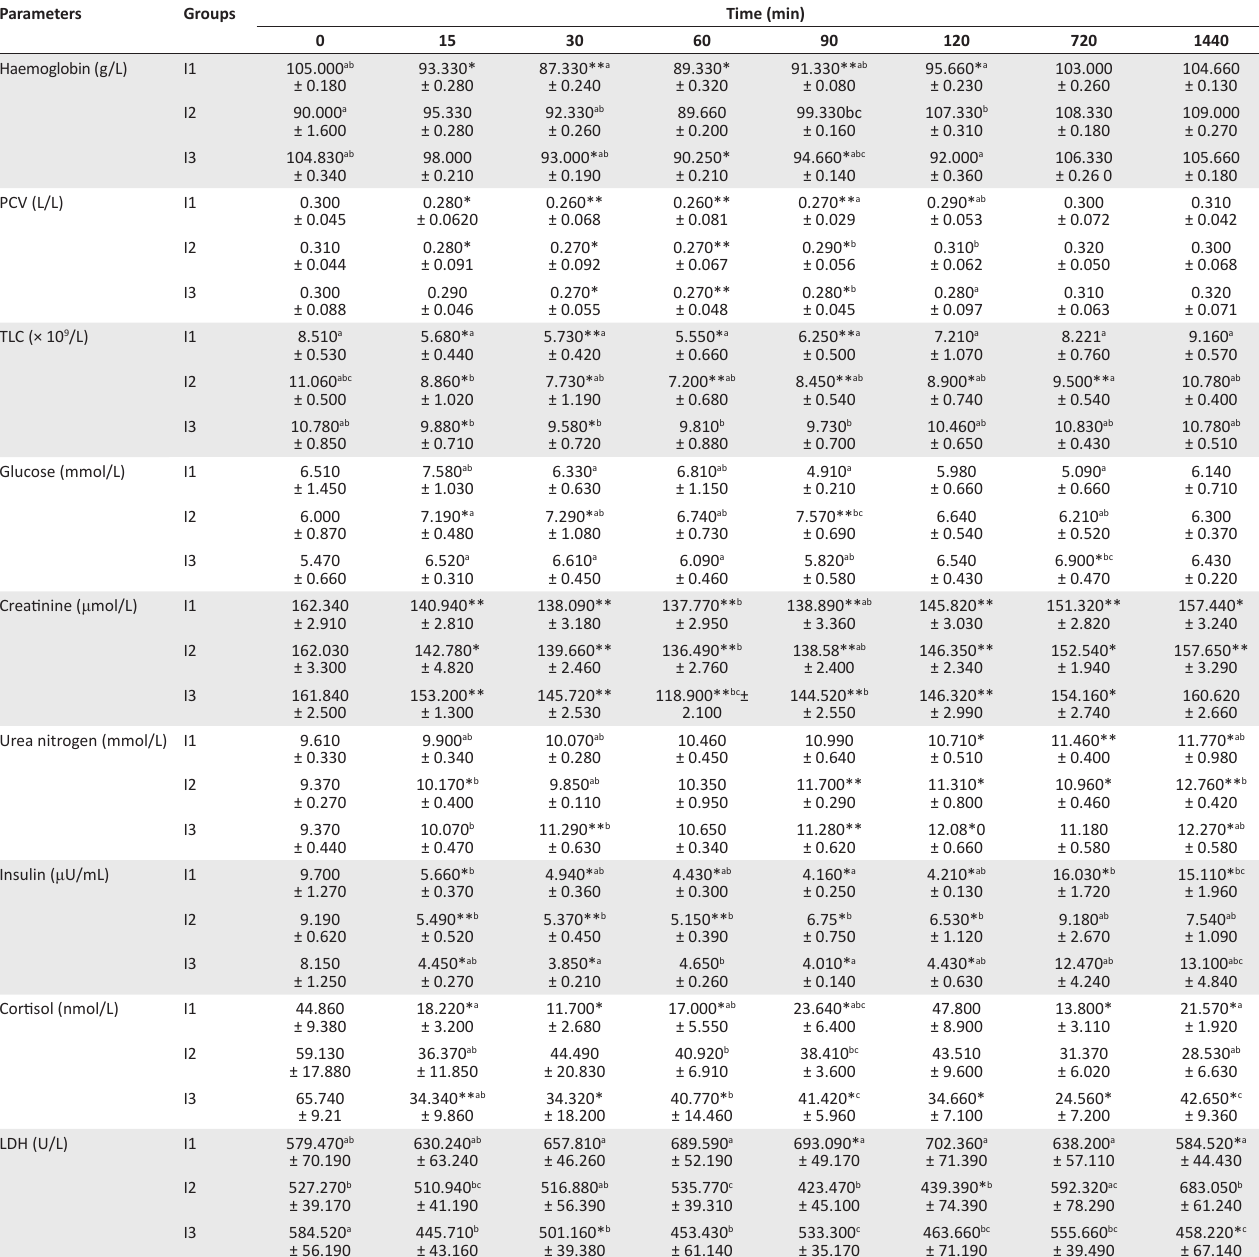
TABLE 2: Mean ± standard error of haematological and biochemical parameters in water buffaloes of different groups. Parameters